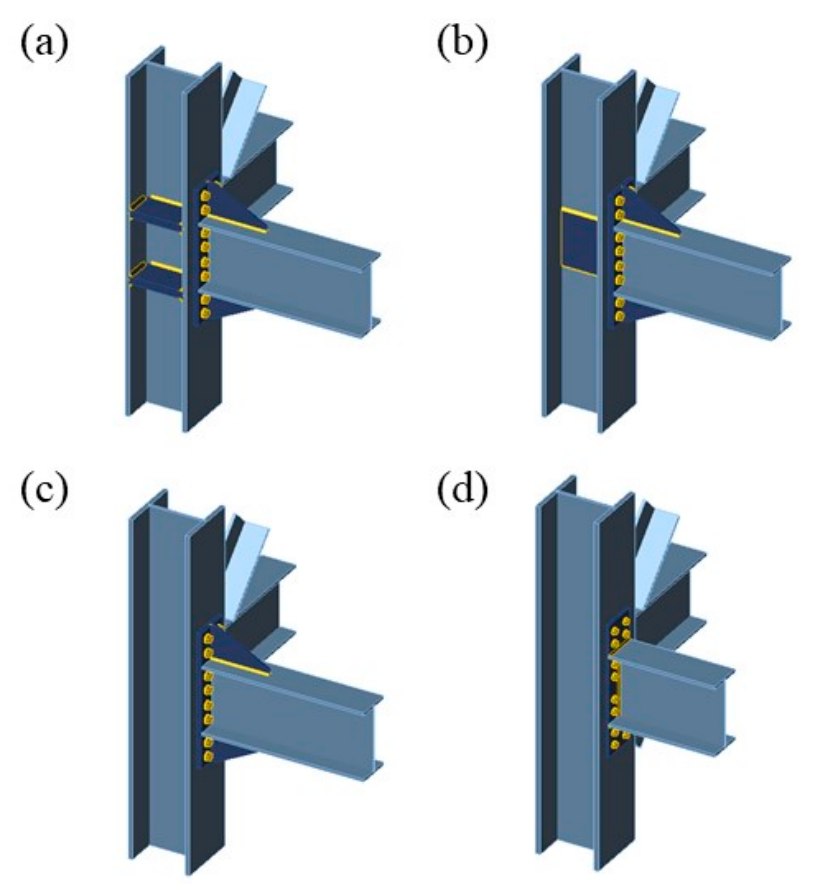
Figure 5. Isometric view of the 8ES EPC ( a ) only with continuity and stiffener plates (CP-ST), ( b ) only with double reinforcement and stiffener plates (DP-ST), ( c ) only with stiffener plates (ST) and ( d ) without reinforcement plate (NP) connections.